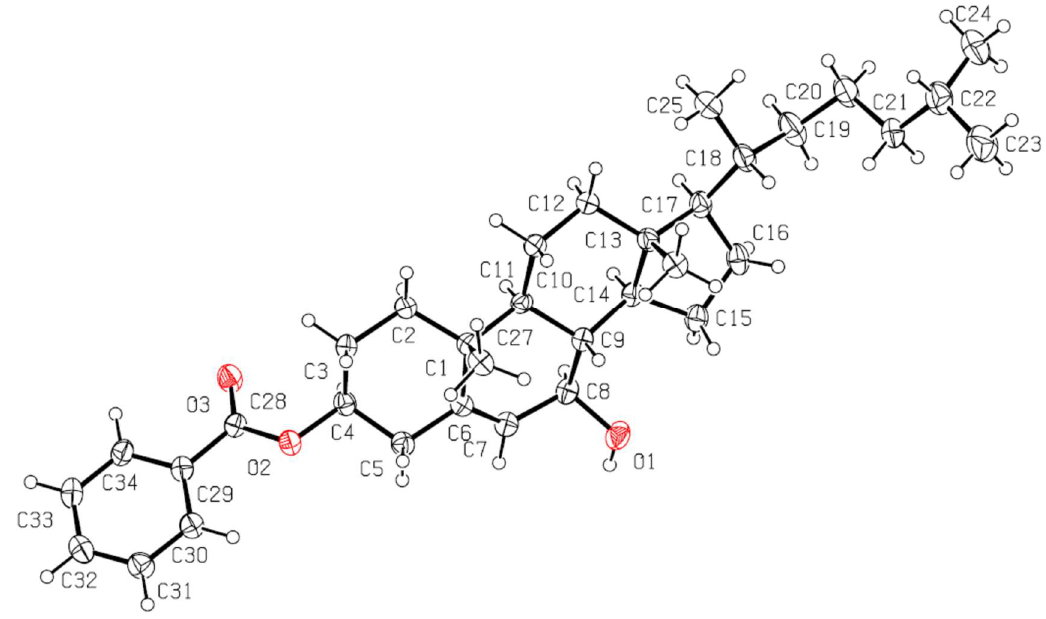
Figure 2. X-ray crystal structure of compound 4a .